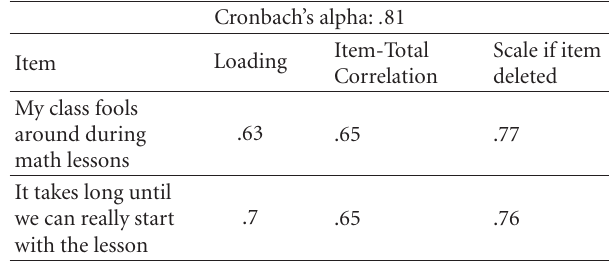
Table 3: Learning environment.